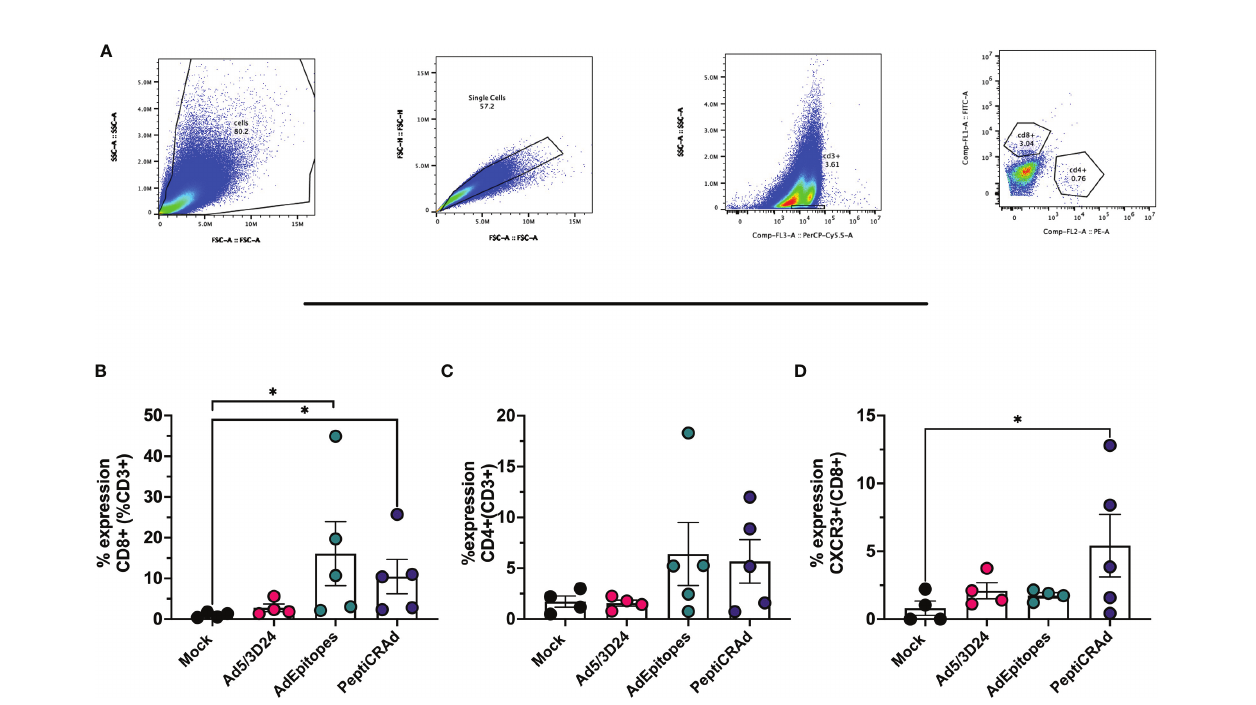
FIGURE 7 | PeptiCRAd induced immune in fi ltration in distant not treated cancer lesions. (A) A representative gating strategy for the fl ow cytometry analysis of the untreated tumors is showed. (B – D) The immunological T cell pro fi le was investigated in untreated lesions by fl ow cytometry. The frequency of CD8+ (B) , of CD4+ (C) and CXCR3+ (CD8+) (D) T cells is shows. All the data are plotted as dot plot for each tumor and for each treatment group as mean± SEM. The signi fi cance was assessed by One way ANOVA and Tukey´s correction (ns P > 0.05, *P ≤ 0.05, **P ≤ 0.01, ***P ≤ 0.001, P ≤